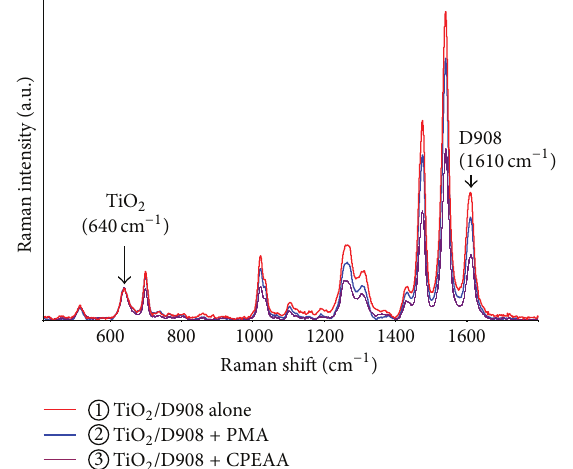
Figure 6: Nyquist plots for the DSC devices using TiO 2 films sensitized with D908 alone, D908 with PMA, and D908 with CPEAA.